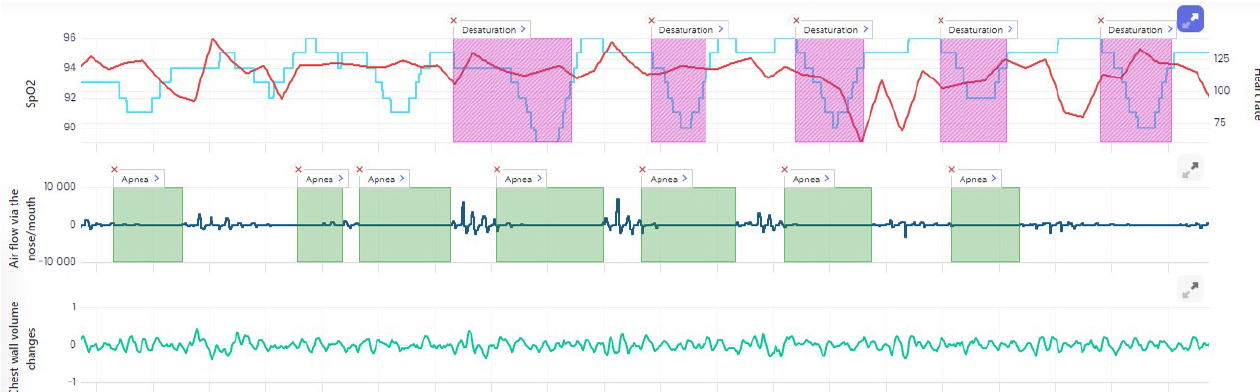
Figure 4. Sleep apnea reading, confirmed by